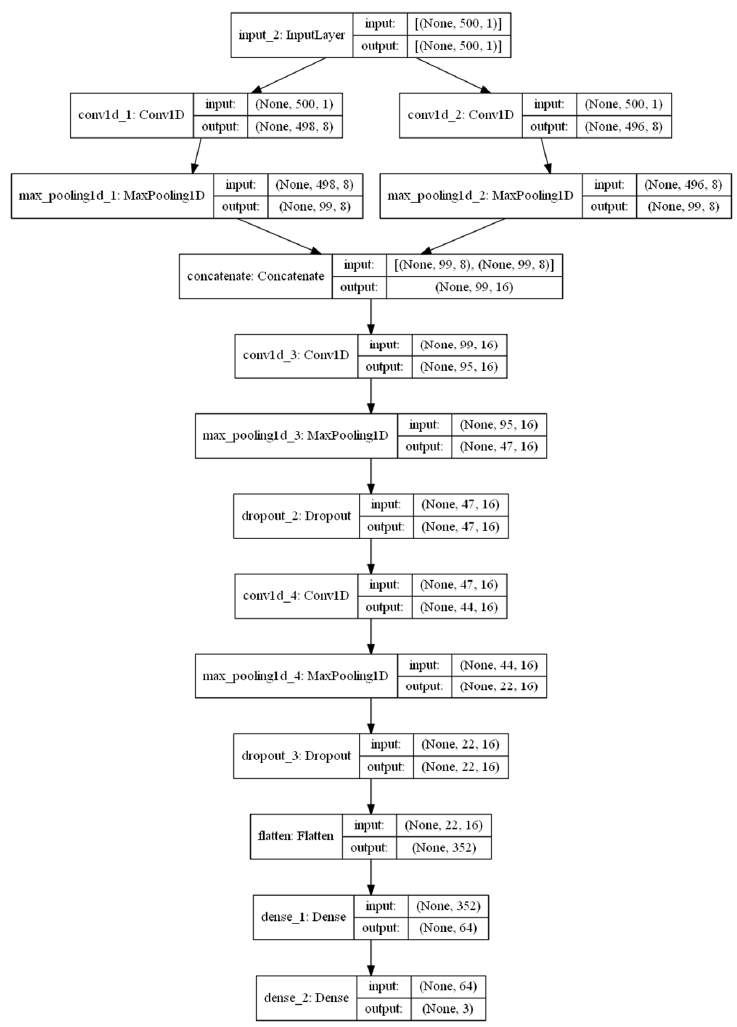
Figure 4. Architecture of the proposed C-CNN model. Table 1. Sample of iterations for Hyperparameter Optimization.